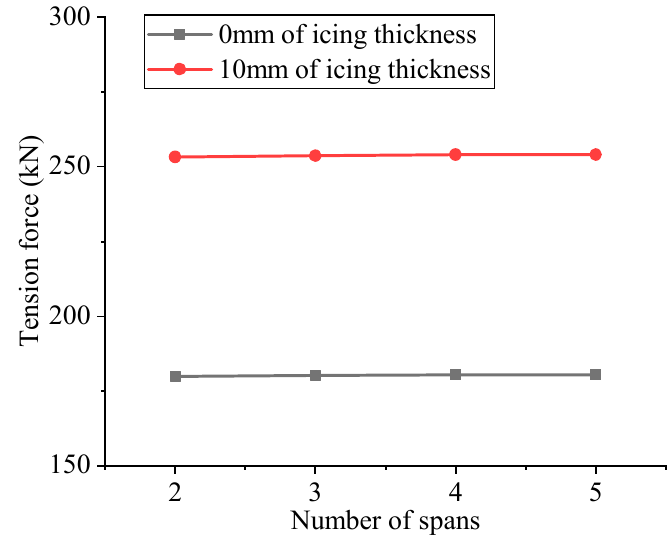
Figure 18. The influence of number of spans of conductor on tensile force of suspension cable (wind speed: 10 m/s).